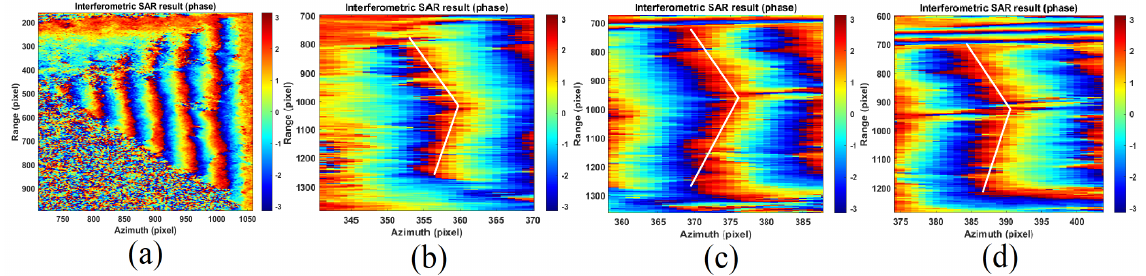
Figure 18. Representation in particular of the pyramid of Kefren. Interferometric phases. ( a ): south side. ( b – d ): magnification of interferometric fringe 1, 2, and